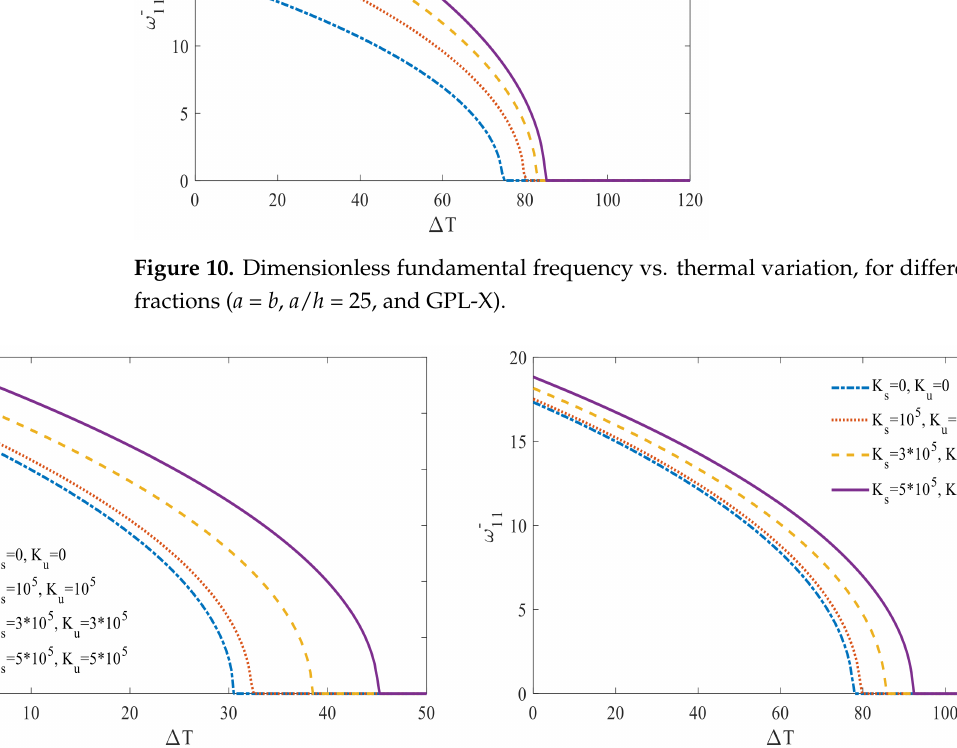
Figure 11. Dimensionless fundamental frequency vs. thermal variation, for different Kerr substrate coefficients ( a = b ,